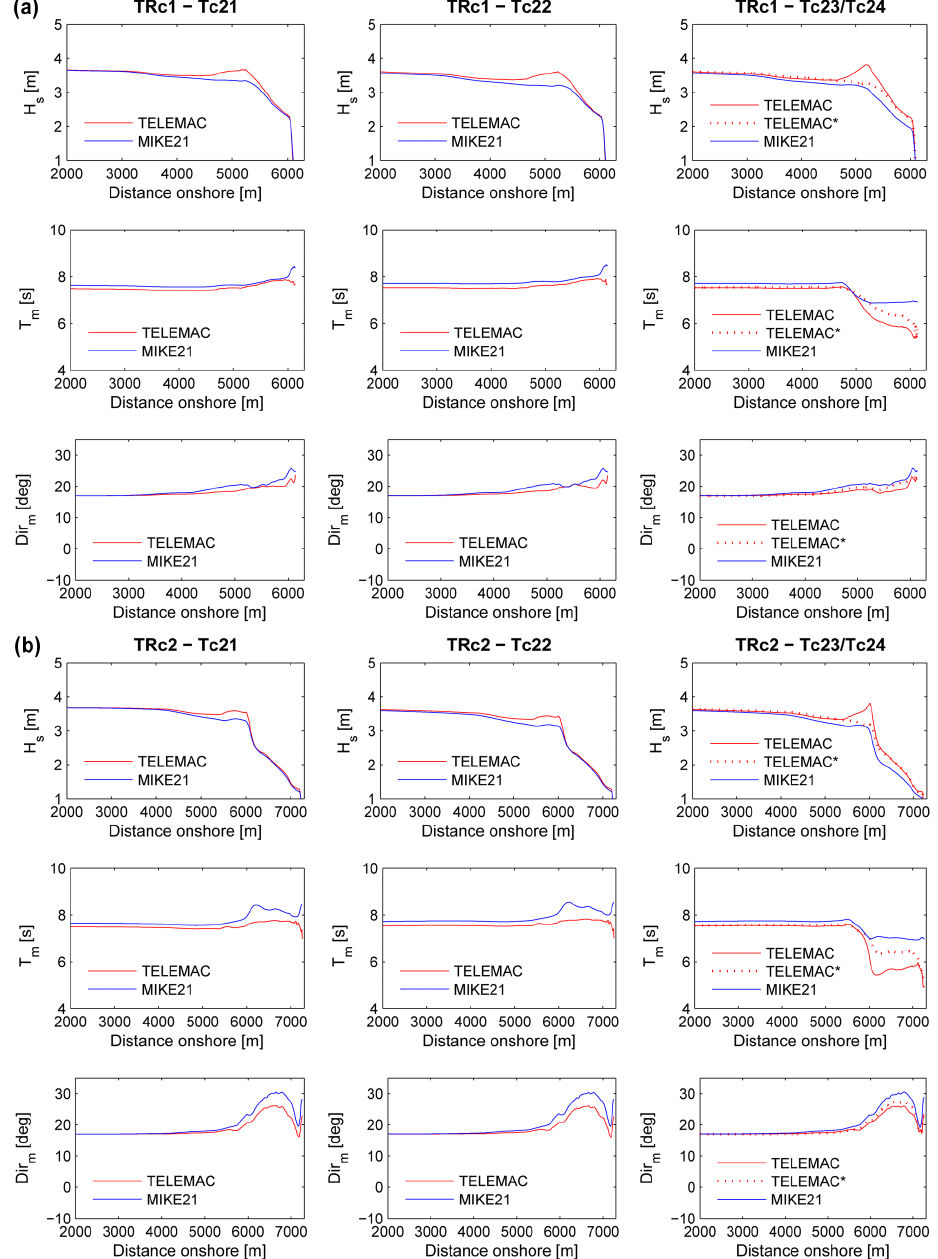
Figure 7. Comparison of TELEMAC and MIKE21 results ( H s − T m − Dir m ) along transects (a) TRc1 and (b) TRc2, for the Brindisi–Torre Guaceto case study (forcing WE2; ∗ =